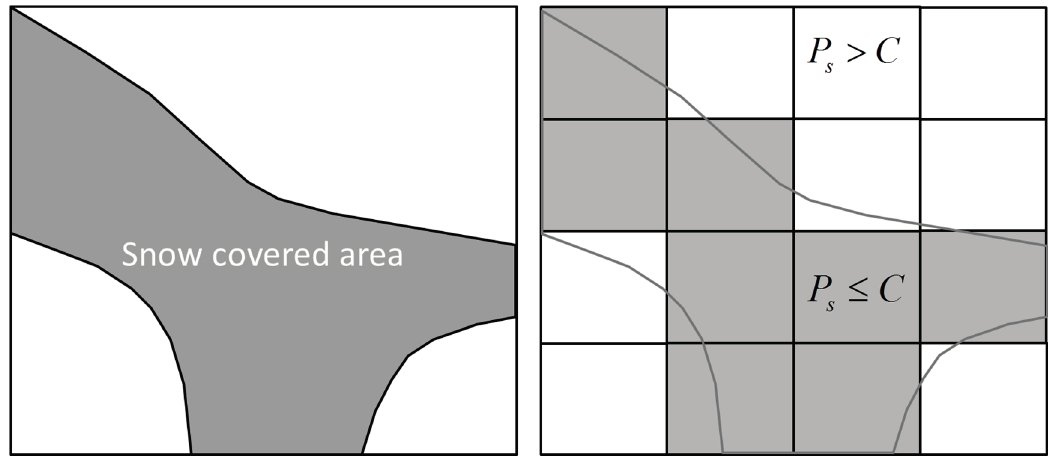
Figure 1. An illustration of snow locations. The left image shows a snow-covered grid. The right-hand image presents the same grid divided into multiple subgrids. It is assumed that P s is greater than C in snow-covered subgrids